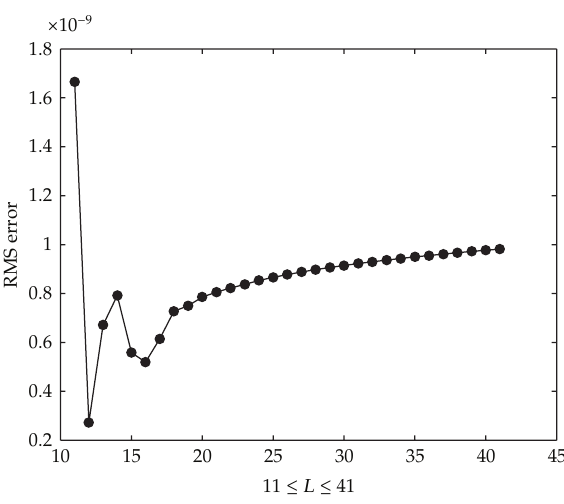
Figure 3: RMS errors at T versus GCL grid points in time direction for Problem